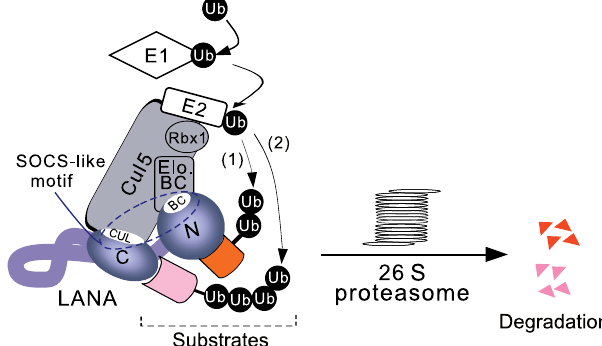
Figure 8. A Model for KSHV LANA Assembles EC 5 S Ubiquitin Complex to Target Downstream Substrates for Degradation LANA is predicted to form a complex with Cul5/Rbx1 that interacts with Elongin BC but not LANA D SOCS (Cul box and BC box) mutant. LANA acts as adapter to link substrates which bind at its amino (1) or carboxyl (2) -terminal domain (like VHL and p53 ) to EC 5 S ubiquitin complex and induces the pathway of ubiquitin E1 activation, E2 conjugation, and substrate polyubiquitylation as well as 26S